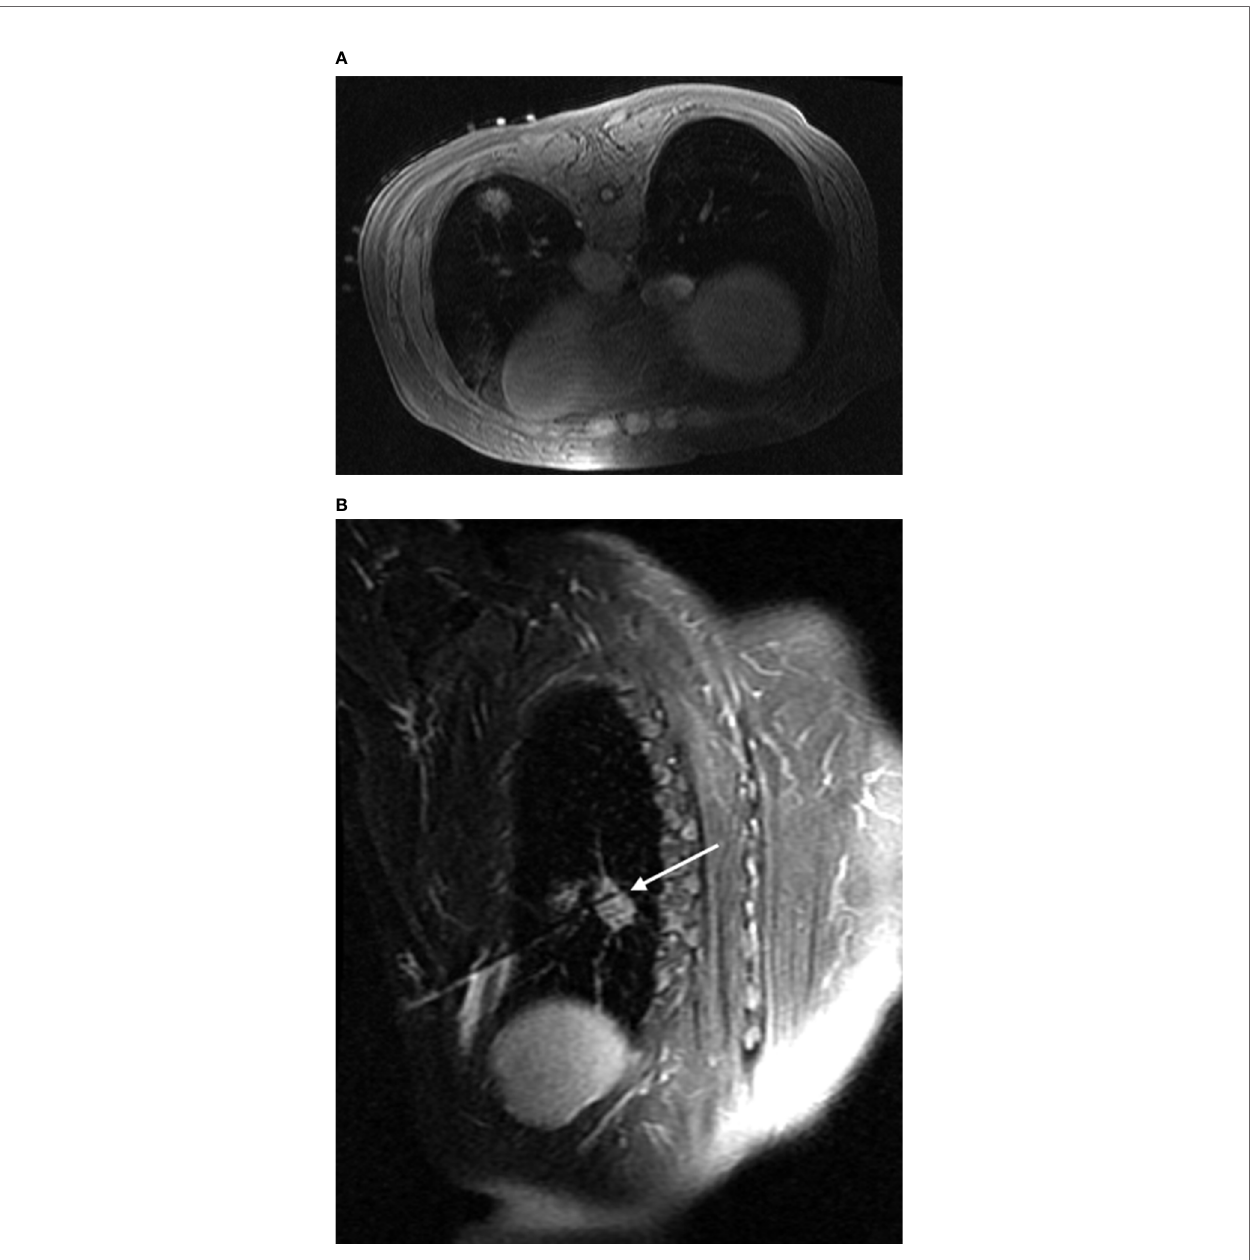
FIGURE 2 | Intraoperative scan: Intraoperative scan was acquired with the patient in the prone position. The lesion showed isointense signals on T1WI, and the hyperintensity marker (cod liver oil matrix) was visible on the patient ’ s surface (A) . In the oblique sagittal fsFRFSE T2WI view with the microwave antenna as the long axis, the lesion was seen as high signals, while the microwave antenna displayed as a strip of low signals surrounded by a small amount of high signal due to hemorrhage [ (B)